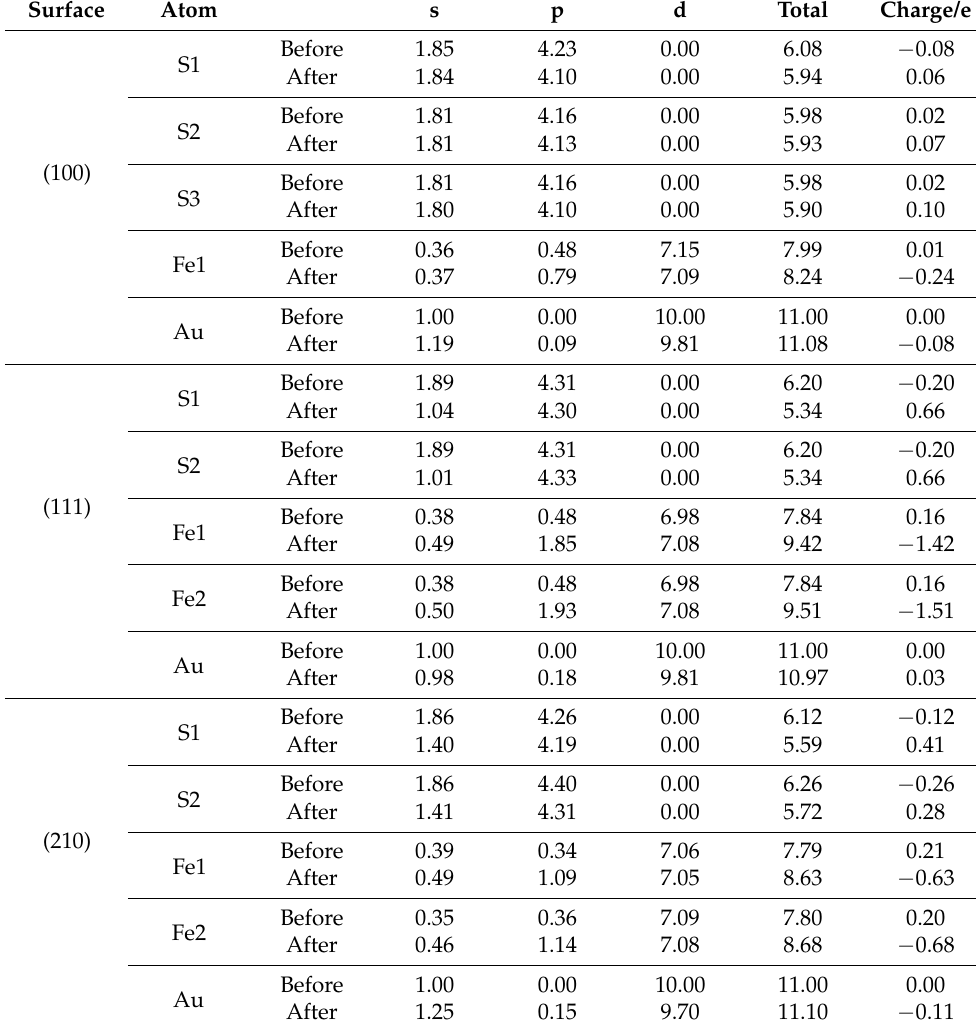
Table 4. Mulliken charge population of atoms before and after Au adsorption on the pyrite surface. Surface Atom s p Before